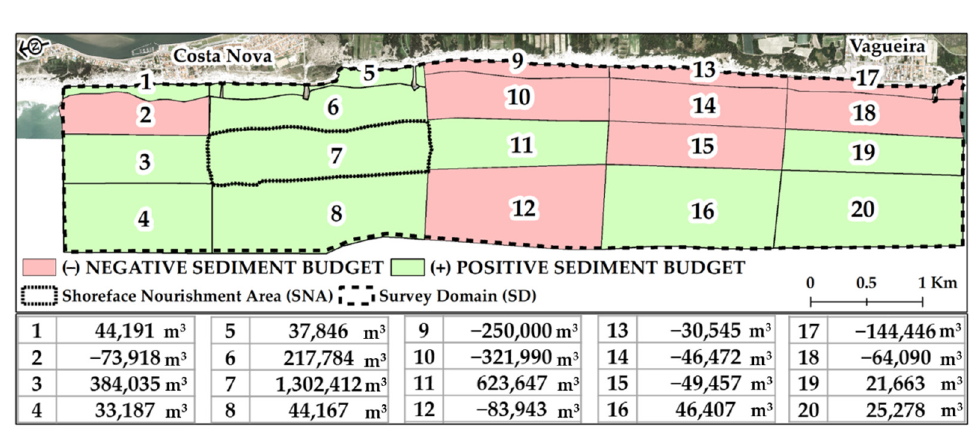
Figure 10. Multiple Monitoring Cell (MMC) approach with sediment budget along the SD between